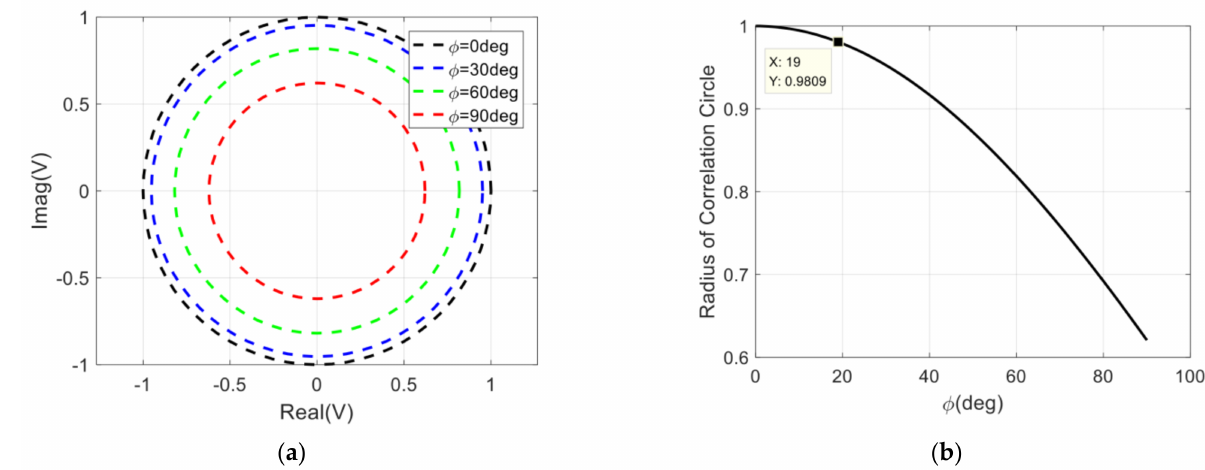
Figure 5. Influence of PSRE on correlation results: ( a ) The variation of the correlation circle with the PSRE; ( b ) The variation of the radius of the correlation circle with the